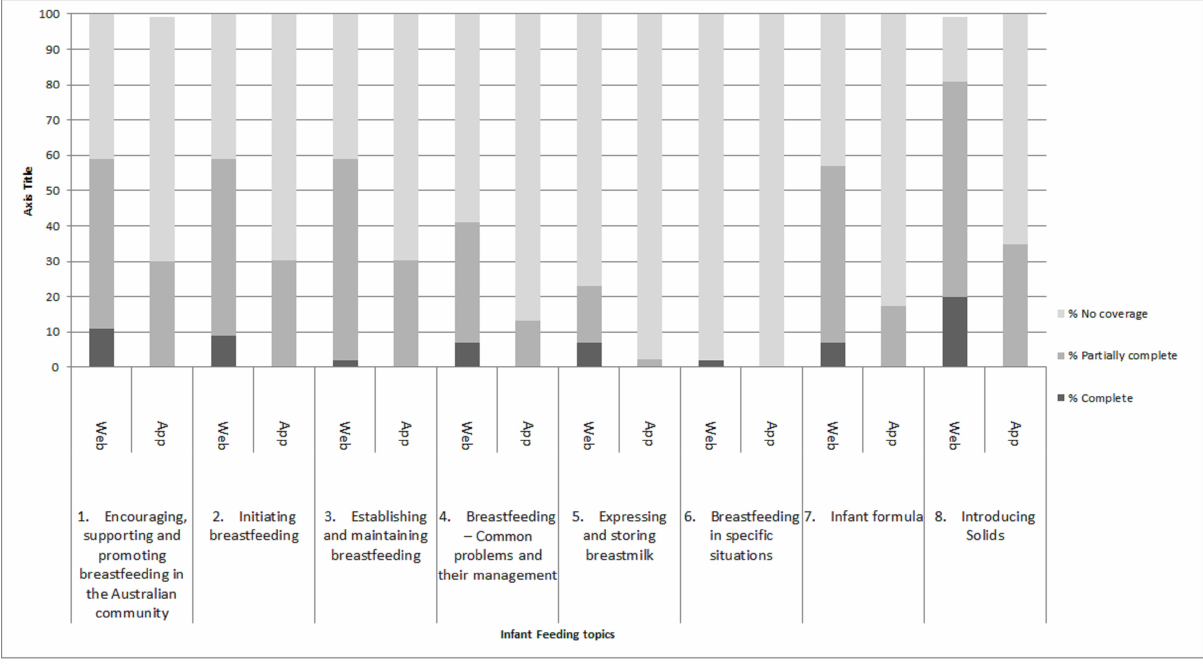
Figure 3. Topics from the Infant Feeding Guidelines provided on websites and apps in this